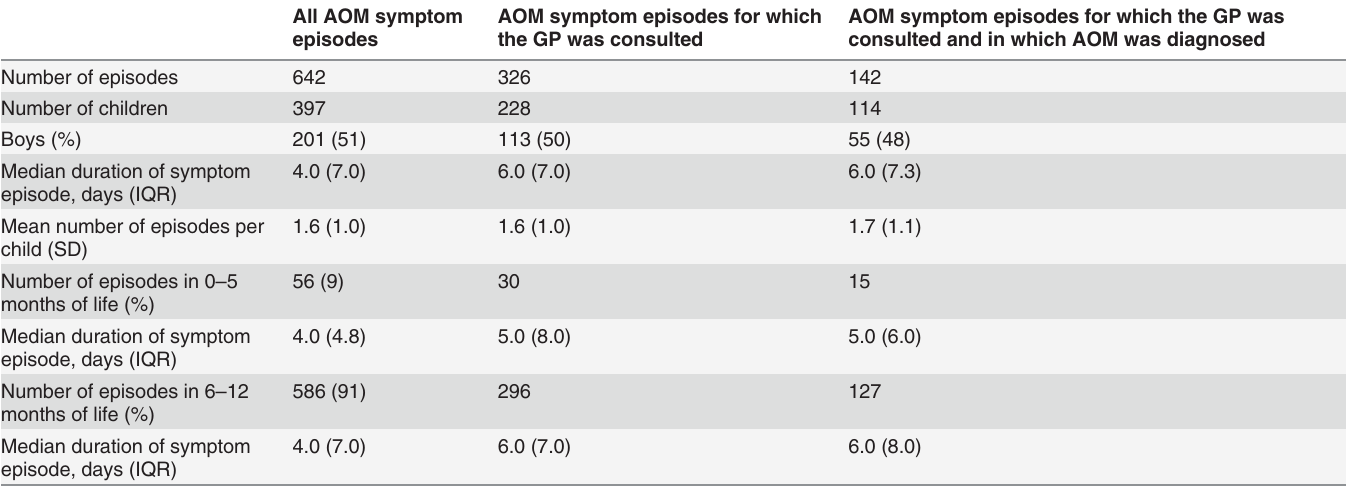
Table 2. Characteristics of febrile AOM symptom episodes stratified by GP-consultation and GP-diagnosis of AOM. All AOM symptom episodes